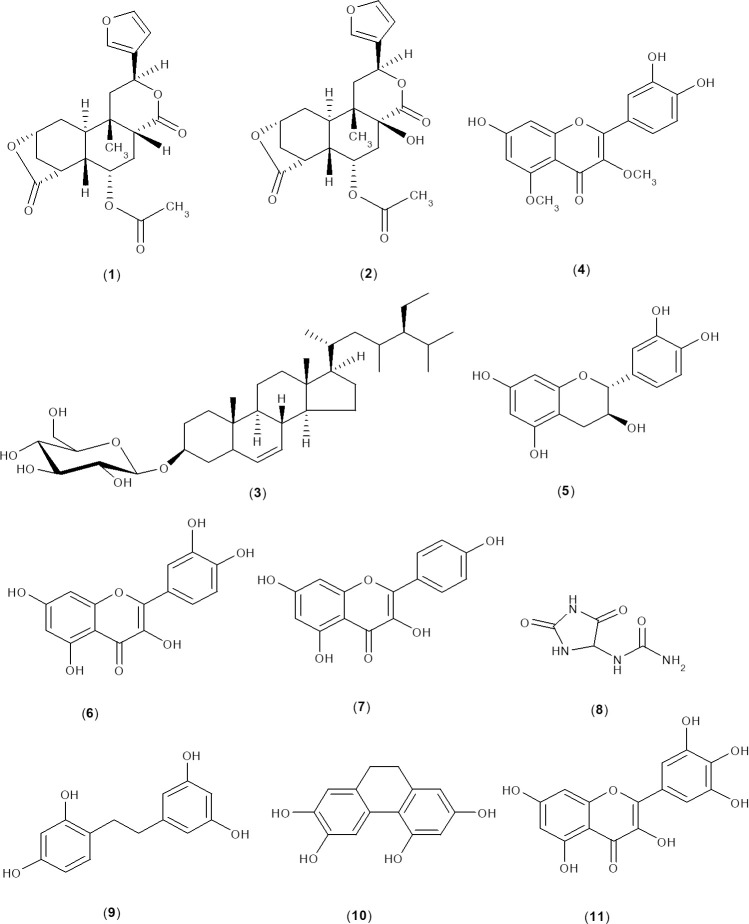
Structures of the compounds isolated from bulbils of D. bulbifera.